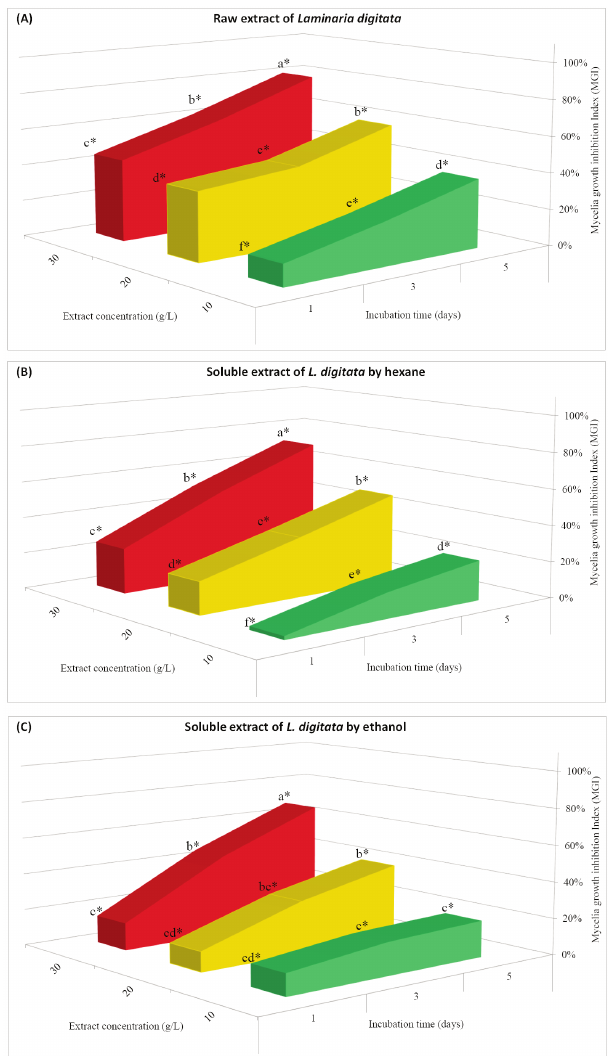
Fig. 1 - Suppressive effect of Laminaria digitata raw extract (A), and soluble extracts by hexane (B) and ethanol (C), on Rhizopus stolonifer mycelia growth inhibition index (MGI%). The suppressive activity of extracts applied at three different concentrations was tested after incuba- tion at 22±1°C for 5 days into Petri plates on PDA medium. Each value, ranging from 0% (no inhibition) to 100% (total inhibition), represents the pooled mean of three replicates with 10 plates for each. MGI% values were collected after 1 d, 3 d and 5 d and analysed by two-way ANOVA. Asterisk indicates P-value ≤0.05 accor- ding to table 1. Histogram points with different letters are significantly different according to Duncan Multiple Test Range (DMRT) at a probability P≤0.05 level.